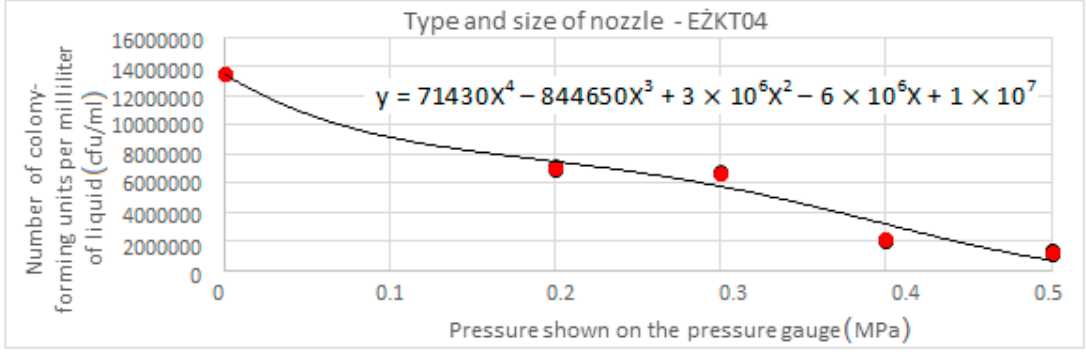
/ mL of liquid for E ˙ZKT03. Agriculture 2020 , 10 , x FOR PEER REVIEW